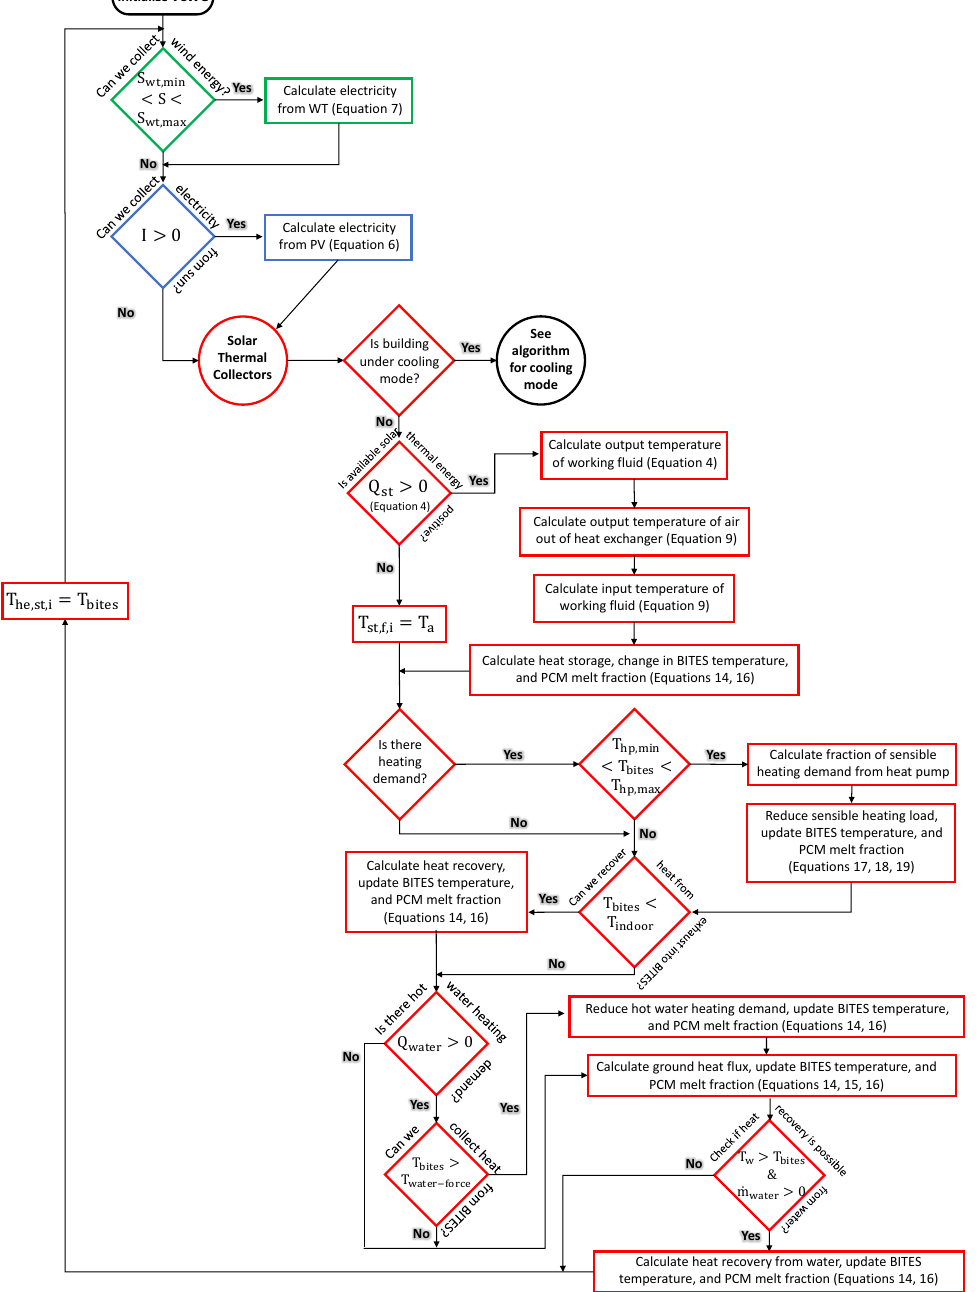
Figure 3. System control algorithm under heating